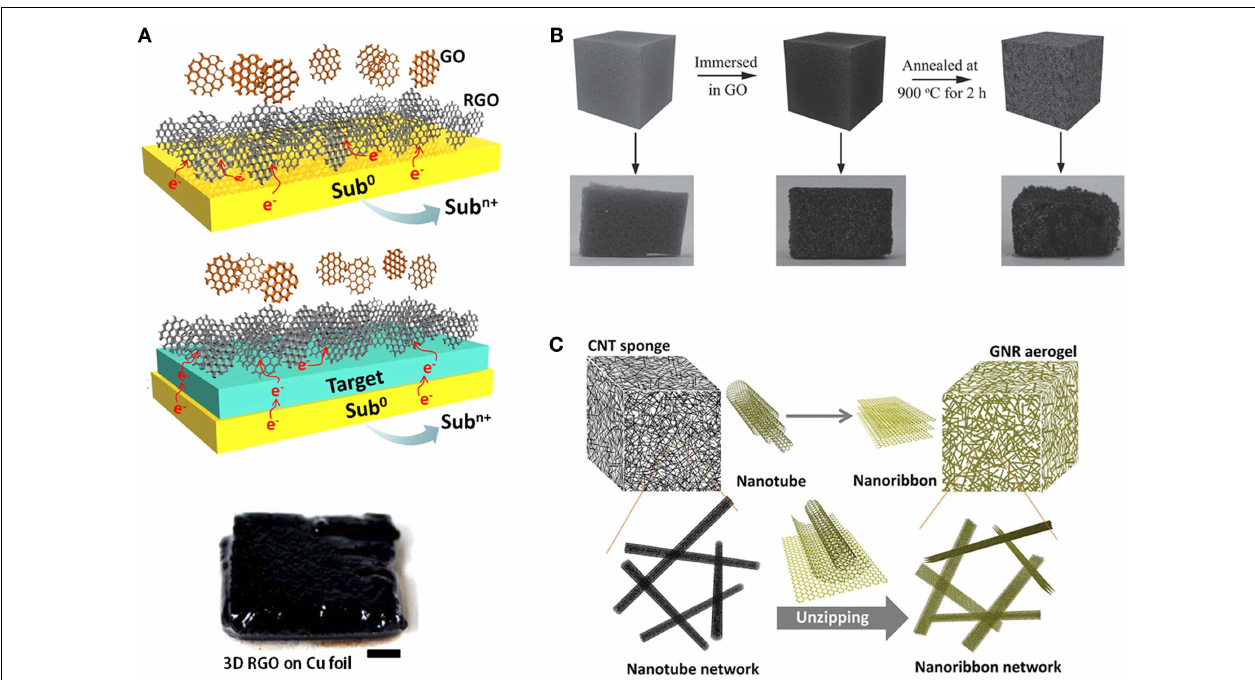
FIGURE 2 | (A) Scheme of the substrate-assisted reduction and assembly of GO on active metal substrate and arbitrary conductive target supported by active metal. Adapted with permission from Hu et al. (2013). Copyright 2013 Nature Publishing Group. (B) Schematic representation and photo images of the procedure for preparing sponge template graphene aerogel. Adapted